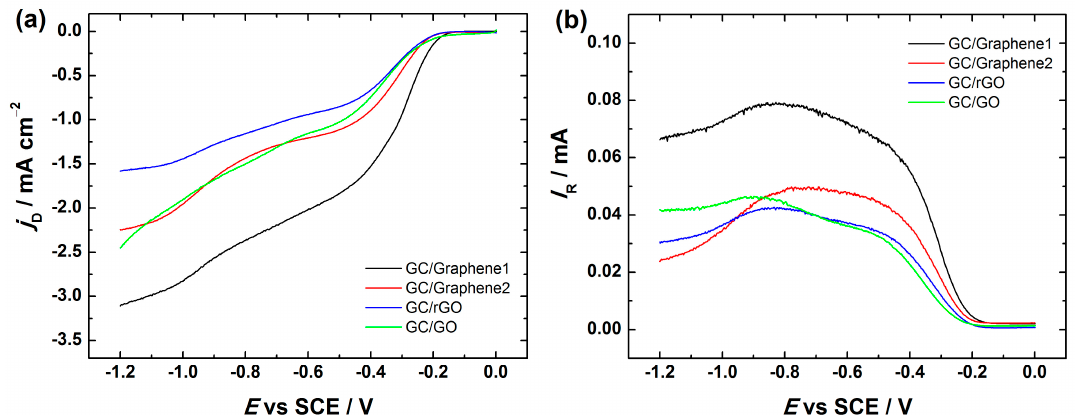
Figure 7. RRDE (rotating ring-disc electrode) voltammetry curves for O 2 reduction and HO 2 − oxidation in O 2 -saturated 0.1 M KOH on GC electrodes coated with graphene nanopowder from Graphene Supermarket (GC/Graphene1), graphene nanoplatelet aggregates from Strem Chemicals (GC/Graphene2), reduced graphene oxide (GC/rGO) and graphene oxide (GC/GO). ω = 960 rpm, ν = 10 mV ∙ s − 1 . ( a ) Disc current densities; and ( b ) ring currents. For GC electrode modification, the catalyst ink suspension in 2-propanol containing OH − ionomer was used.